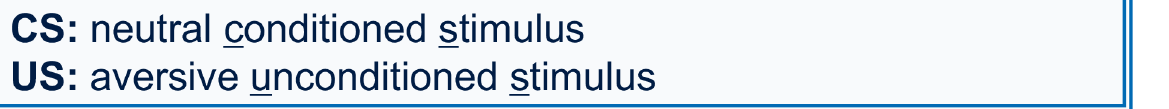
Fig 2. Fear conditioning procedure in the present study. The behavioral procedure consisted of three consecutive phases: habituation, acquisition, and extinction. Subjects received three CSs and an aversive US. The habituation phase comprised 6 trials (2 trials of each CS). In the acquisition phase, one CS was randomly selected from those three CSs and the selected CS was then paired with the US at a partial reinforcement rate of 50% (i.e. CS+). Other two CSs were presented without pairing the US during the acquisition phase (i.e. CS-). The acquisition phase included 36 trials (12 trials of each CS). The extinction phase consisted of 18 trials (6 trials of each